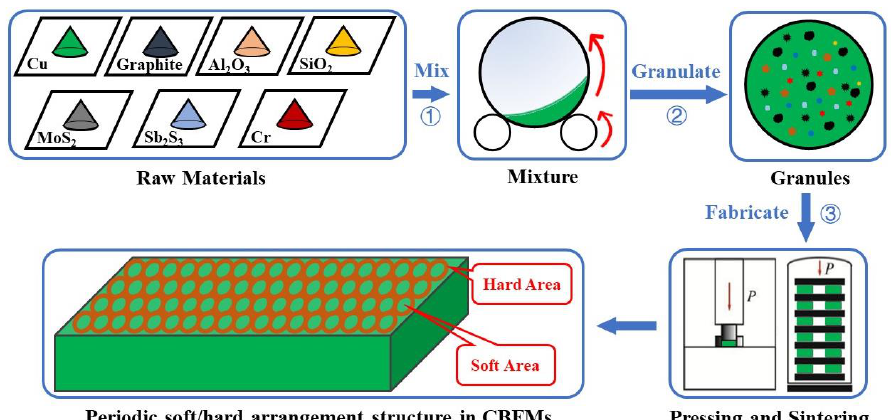
Figure 1. The fabrication process of CBFMs.